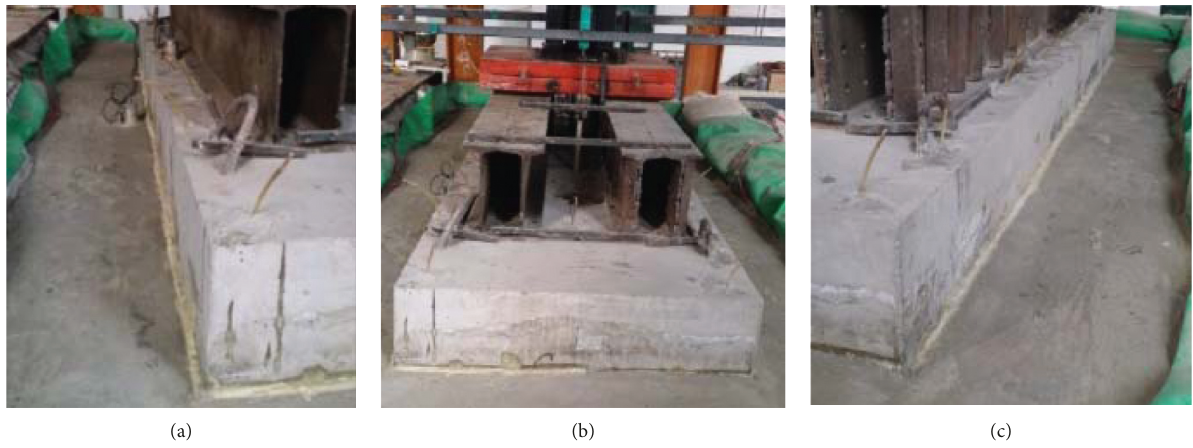
Figure 8: The full-scale model with mud pumping after reinforcement.